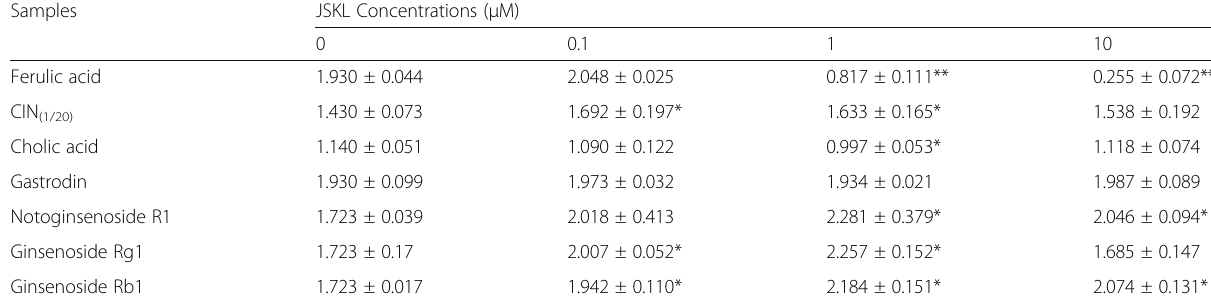
Table 3 Effects of monomeric compounds with different JSKL concentrations on the activity of MH7A cells